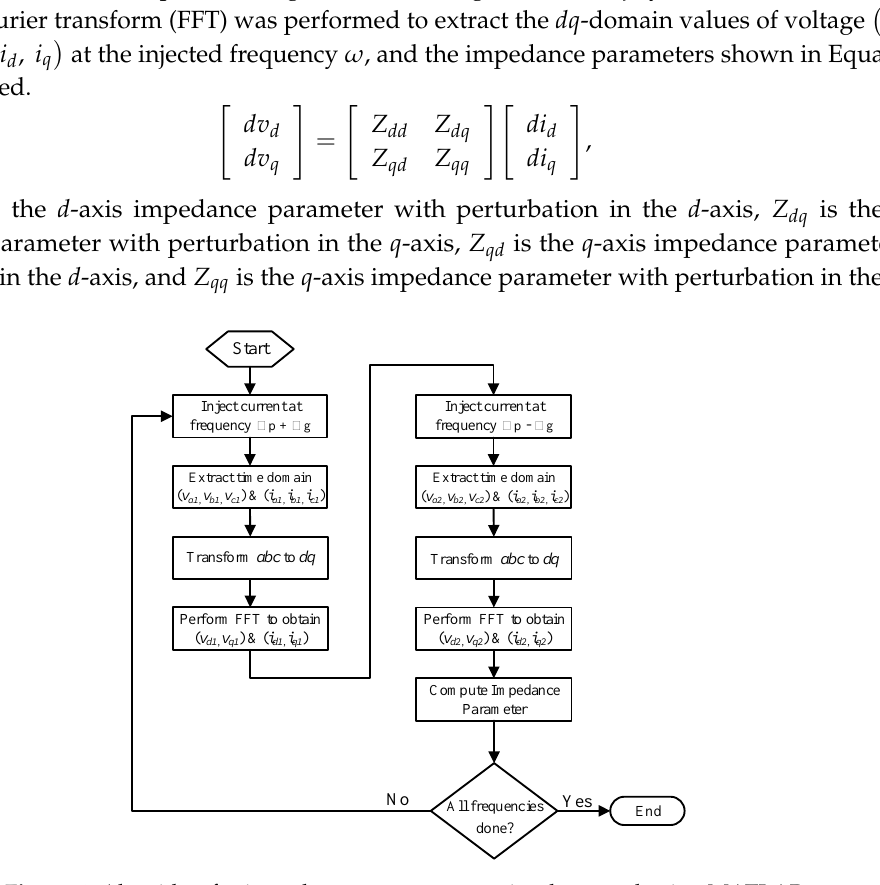
Figure 4. Algorithm for impedance measurements implemented using MATLAB.